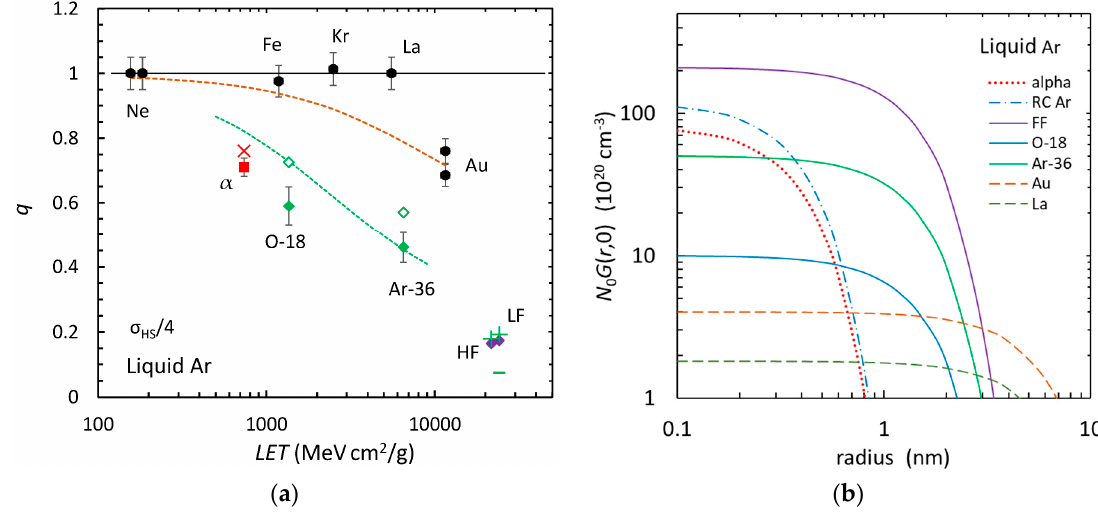
Figure 1. ( a ) Quenching factor q for various ions as a function of linear energy transfer (LET) in liquid Ar. Measurements are as follows: 5.305 MeV 210 Po α -particles ( ▪ ), relativistic heavy ions (RHIs) of ~1 GeV/n ( ● ) [12], 33.5 MeV/n 18 O and 31.9 MeV/n 36 Ar ions (closed diamonds) [14] and 252 Cf fission fragments (closed diamonds) [12]. Heavy fragments (HFs) and light fragments (LFs) are shown separately. Crosses (×,+) show the results calculated numerically for the hard-sphere cross-section divided by 4, σ HS /4. The previous result obtained for LFs with T c / T = 1 is also shown (-). Dashed curves show Birks’ law applied to the numerical calculation for core quenching (Equation (27)) as shown in Figure 3b. RHIs and nonrelativistic ions ( 18 O, 36 Ar and FFs) are treated separately. Open diamonds show q obtained by the sum of scintillation and charge signals [14] (see Section 4.3). ( b ) Initial radial distribution of excited species, essentially the same as the prompt dose profile, in the cylindrical track core produced by various ions in liquid Ar (see Section 2.1). The distribution for 30 keV Ar recoils (RC Ar) is also shown (dot-dashed curve). A Gaussian distribution is assumed.